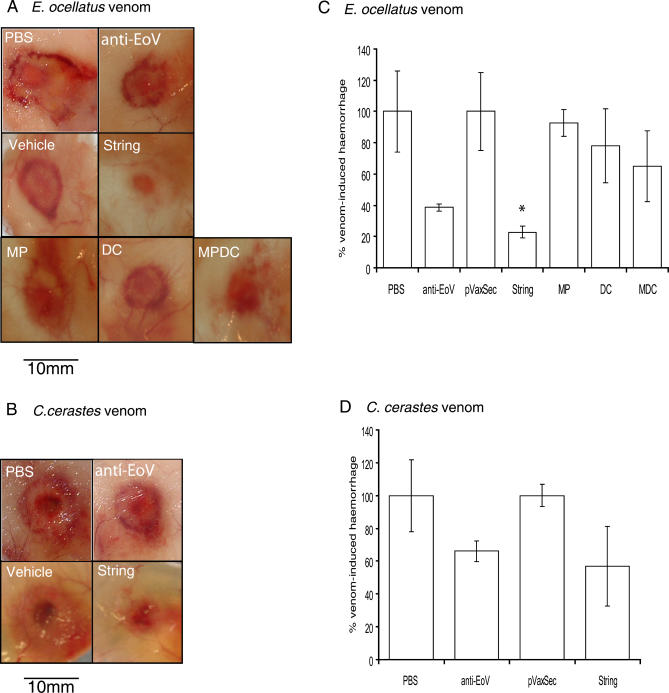
Neutralization of Venom-Induced Hemorrhage(A and B) Representative hemorrhagic lesions in the skin of mice injected with one minimum hemorrhagic dose of
E. ocellatus venom (A) and
C. cerastes venom (B) following preincubation with PBS, rabbit anti-
E. ocellatus venom (anti-EoV), or pooled sera from mice immunized with the indicated DNA immunogens.
(C and D) The above data expressed as mean standardized area of hemorrhage on the inner surface of the skin (± 1 standard error of the mean). Values are expressed mean percentage hemorrhage relative to control, pVaxSec (DNA immunogens), or PBS (protein immunogens) which was taken as 100%. A result statistically significant relative to controls is denoted by an asterisk.